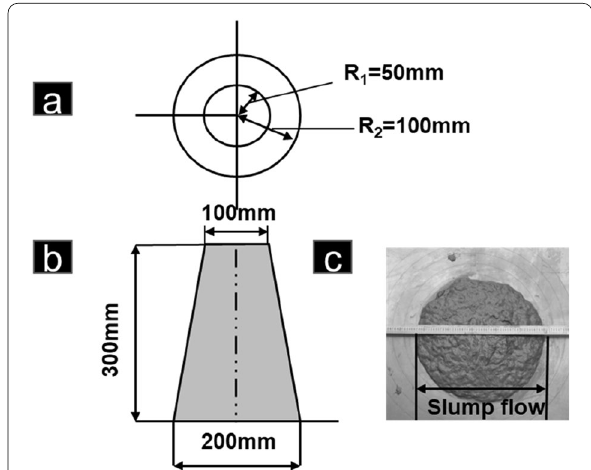
Fig. 3 Schematic diagram of the slump cylinder. a Top view of the slump cylinder; b front view of the slump cylinder; c measured slump flow of HFRMPC slurry.